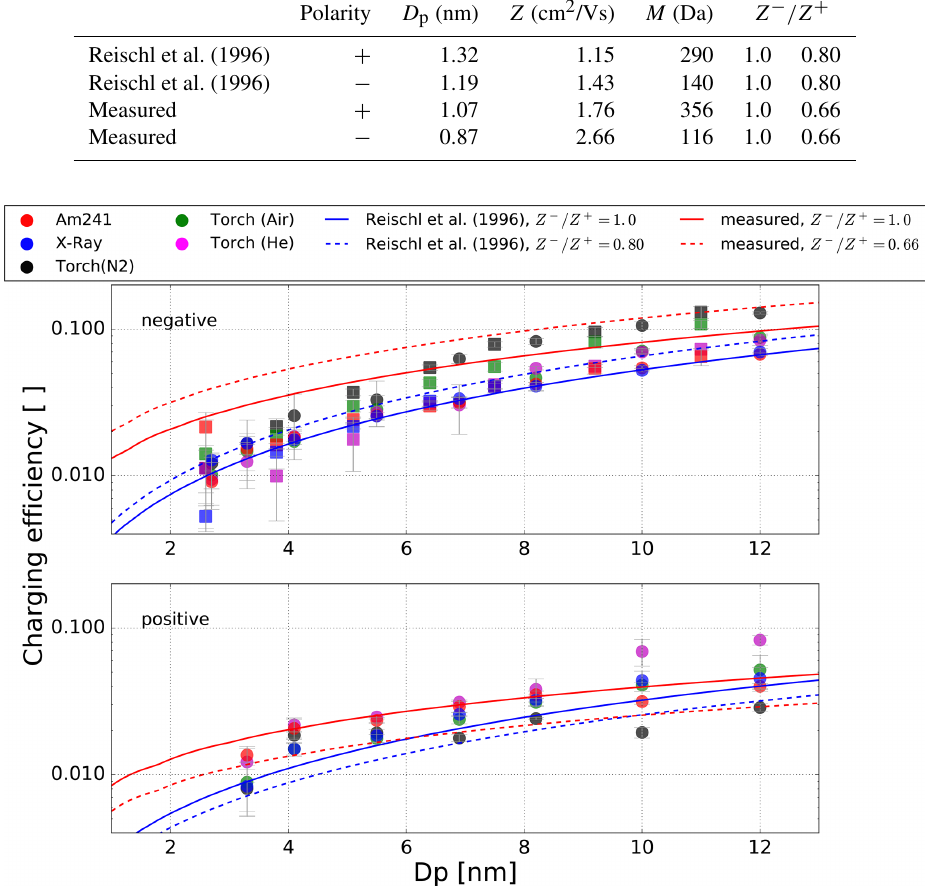
Figure 7. Measured charging efficiencies for the different aerosol chargers for negatively and positively charged Ag particles (dots) and negatively charged NaCl particles (squares) with mobility diameters less than 12nm. The lines represent the charge distribution according to Fuchs theory; the parameters for the ion mobilities, ion masses and ion mobility ratio are listed in Table 4. The collision probability of ions was calculated following Hoppel and Frick